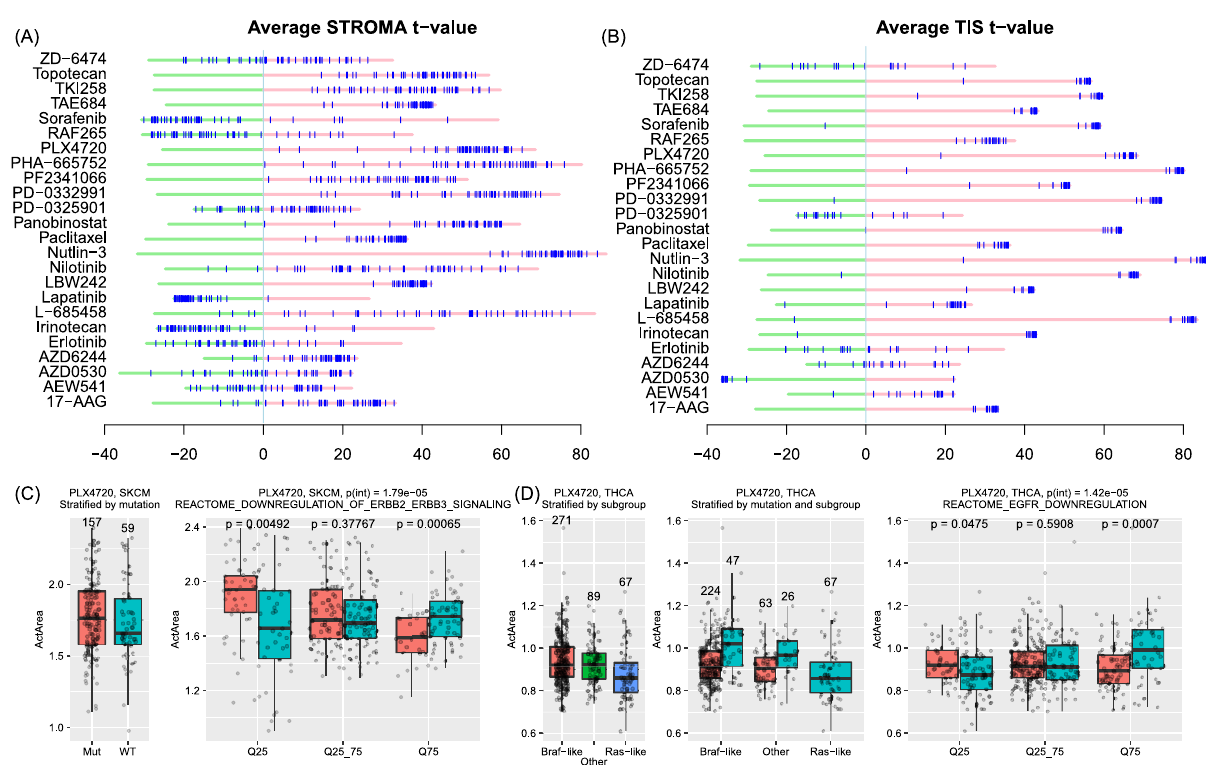
Fig. 8 Drug response with tumor heterogeneity. A Distribution of gene t-scores for all drugs, with stroma genes, highlighted. Stroma genes were found to be negatively associated with several EGFR inhibitors, such as AZD6244, lapatinib, and PD-0325901. B Distribution of gene t-scores with Tumor In fl ammation Score (TIS) signatures. C Investigation of the association between BRAF mutations and PLX4720 response in SKCM. SKCM samples with BRAF V600 mutations (labeled as “ Mut ” on the left panel, n Mut = 157) did not show a signi fi cantly high response to PLX4720 compared to other SKCM samples that had no mutations in BRAF , HRAS , KRAS , NRAS , or EGFR (labeled as “ WT ” on the left panel, n WT = 59). However, this was explained using the “ downregulation of ERBB2 ERBB3 signaling ” pathway activity. In the subgroup where this pathway showed low activity (the lower quartile of all samples ordered by increasing pathway activity, labeled Q25, n Q25 = 91, including n Mut = 48 for samples with BRAF V600 and n WT = 43 for samples without BRAF V600), samples with BRAF mutations had a higher response, implying that the pathway had a confounding effect on the response. In the middle subgroup (Q25_75), there are n Q25_75 = 180 samples with n Mut = 80 samples harboring BRAF V600 mutations and n WT = 100 samples harboring not. In the higher quantile subgroup (Q75), there are n Q75 = 91, including n Mut = 29 for samples with BRAF V600 and n WT = 62. A two-sided t test was conducted in each subgroup to compare the predicted response between the samples with the BRAF V600 mutation ( n Mut ) and samples without BRAF V600 mutations ( n WT ). D Investigation of the association between BRAF mutations and PLX4720 response in THCA. THCA samples were grouped into three subtypes according to the original publication: Braf-like ( n = 271, where n = 224 harboring BRAF V600 mutations and n = 47 not), Ras-like ( n = 67, where all having not the BRAF V600 mutation), and others ( n = 89, where 63 harboring BRAF V600 mutations and n = 26 not). When stratifying the samples by the EGFR downregulation pathway activity, the samples in each subgroup were as below: n Mut = 42 and n WT = 81 in the Q25 subgroup, n Mut = 170 and n WT = 74 in the Q25_75 subgroup, and n Mut = 75 and n WT = 48 in the Q75 subgroup. In each subgroup, a two-sided t test was conducted to compare the response between the samples with BRAF V600 mutations ( n Mut ) and samples without ( n WT ). In the boxplots ( C , D ), each box shows the interquartile range (IQR between Q1 and Q3) for the corresponding set. The central mark (horizontal line) shows the